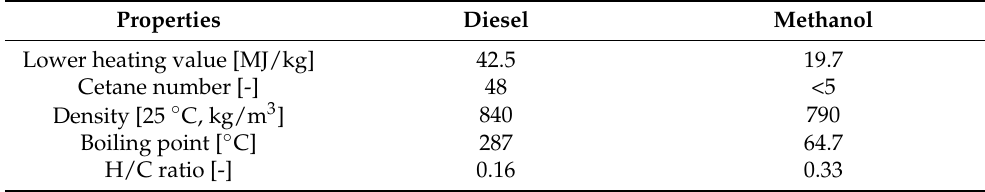
Table 4. Fuel properties.